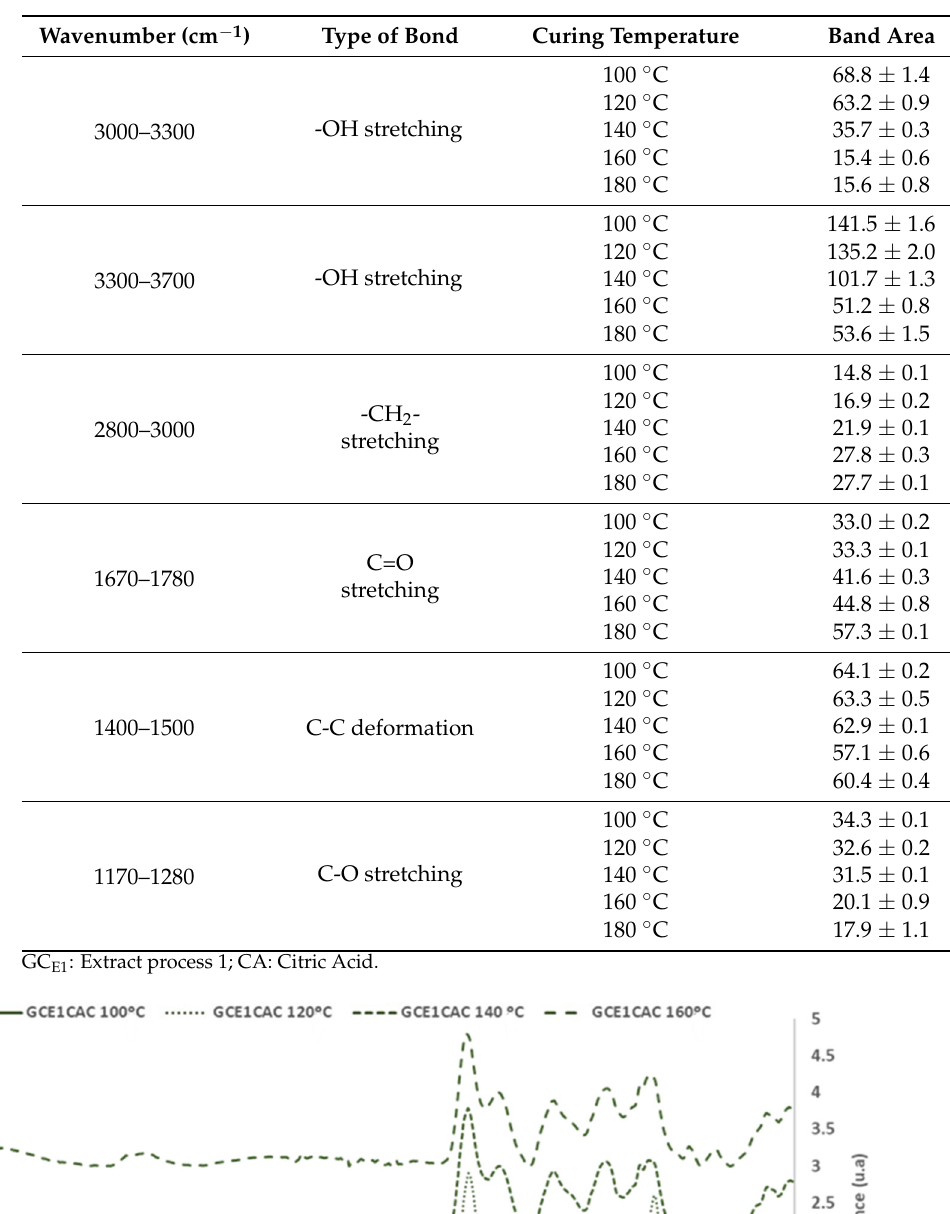
Table 6. Polymerization degree for the GC E1 + CA (33% on adhesive weight, dry basis) cured at 100 –180 ◦ C during 120 s.